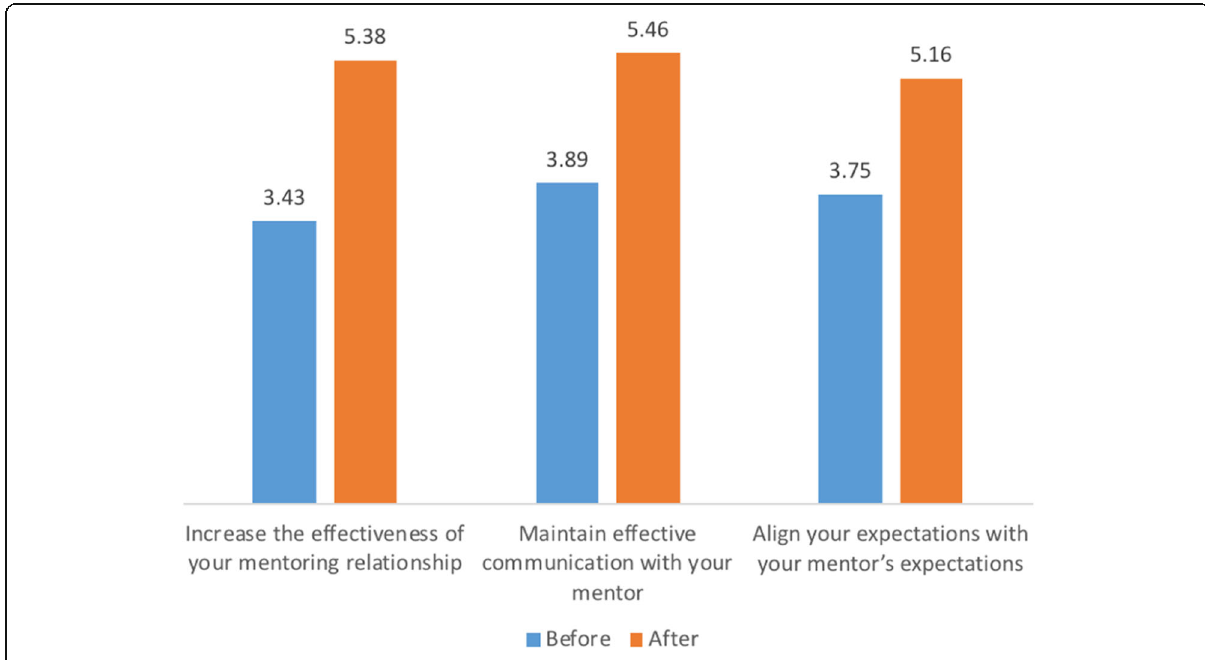
Fig. 8 Growth in confidence in effectiveness of mentoring relationship